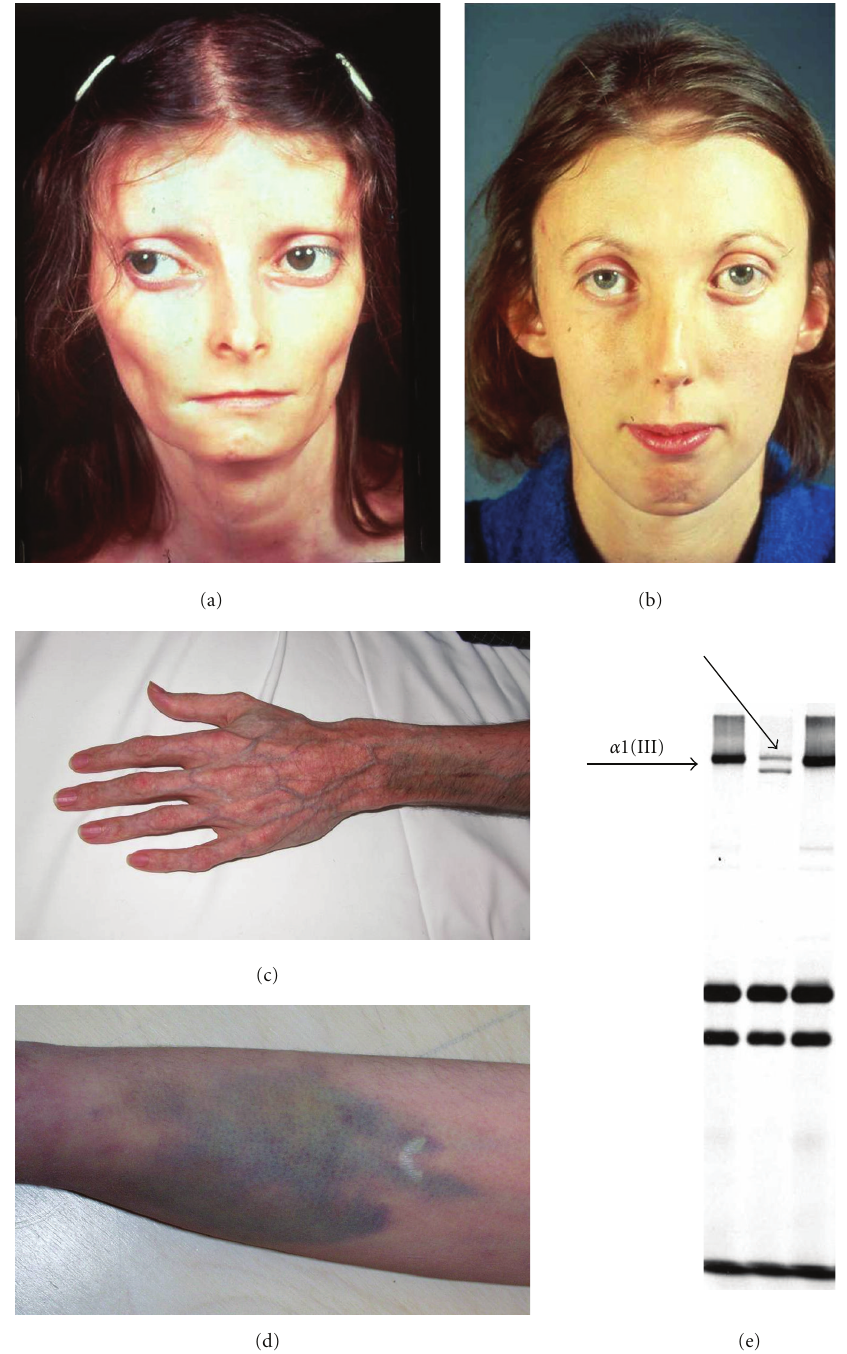
Figure 1: Clinical and biochemical characteristics of the vascular Ehlers-Danlos syndrome. Typical facial features with diminished subcutaneous fat, thin nose and lips (a, b), acrogeria (c) and easy bruising (d). Biochemical analysis of the collagens reveals a diminished amoun of collagen Type III